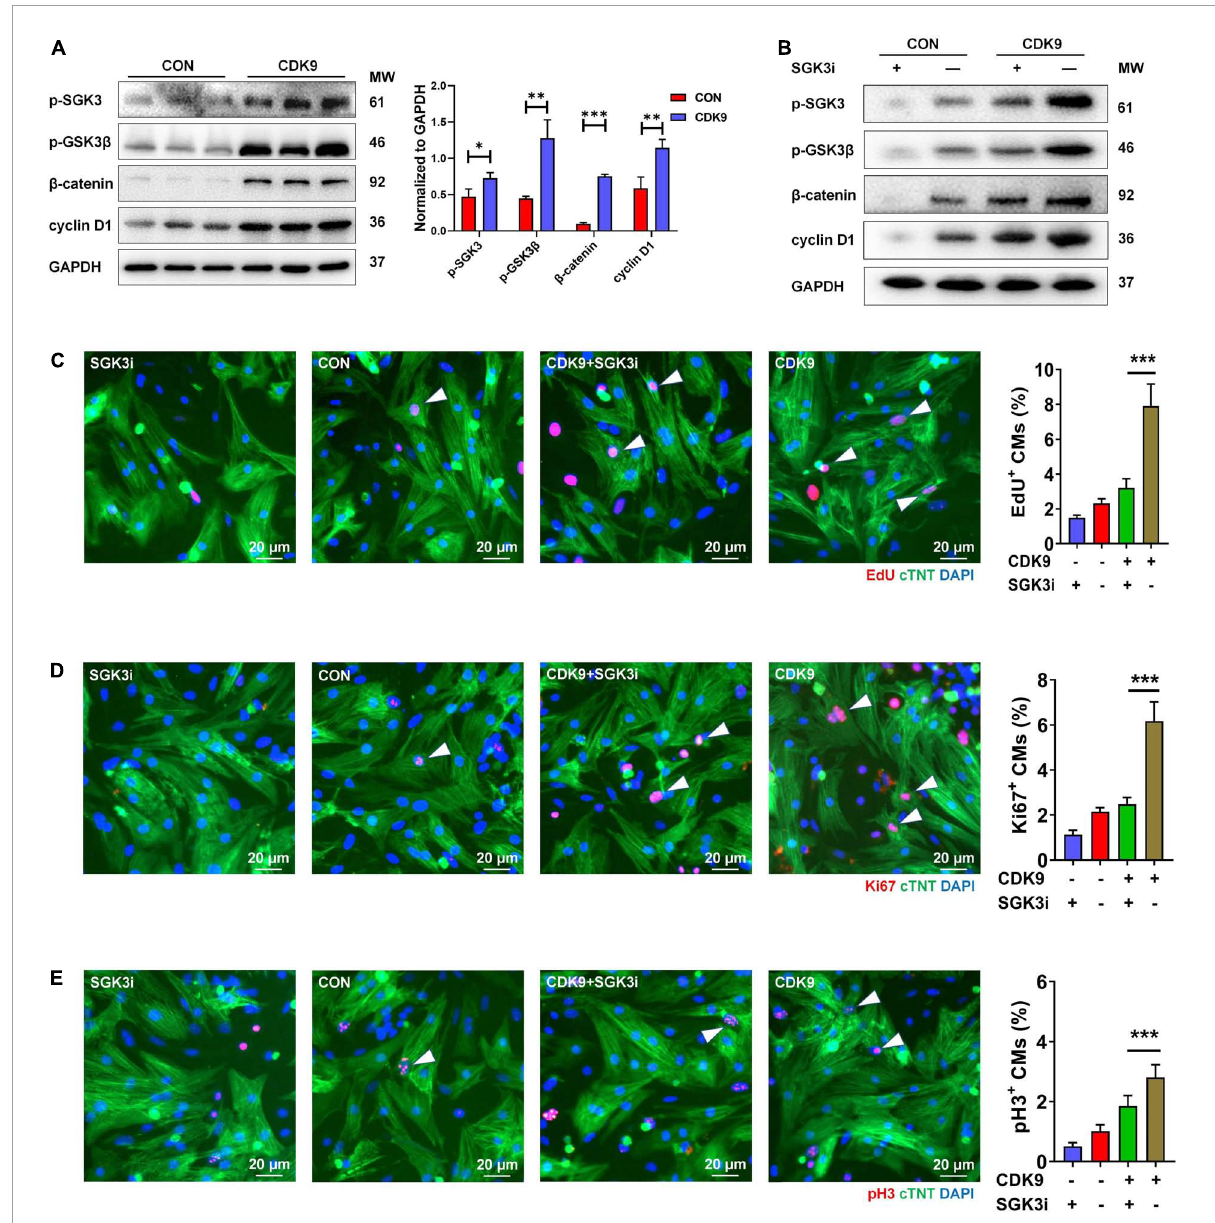
FIGURE6 CDK9 regulates myocardial regeneration and repair through SGK3/GSK-3 β / β -catenin axis in vitro . (A) p-SGK3, p-GSK3 β , β -catenin and cyclin D1 proteins of ventricular myocardium in adult mice injected with Ad5: cTnT-CDK9 (CDK9) after MI detected by western blot. (B) p-SGK3, p-GSK3 β , β -catenin and cyclin D1 proteins of neonatal CMs were detected by western blot after being transfected with CDK9 and/or Ad5:SGK3 RNAi (SGK3i). (C–E) CM proliferation is quantified by immunofluorescence for DNA synthesis (C) , cell-cycle activity (D) , and mitosis (E) in CMs transfected with CDK9 and/or SGK3i ( n = 6). Scale bars, 20 µ m; CMs indicate cardiomyocytes, MW indicates molecular weight; statistical significance was calculated with the unpaired Student t -test; data are presented as mean ± SEM, * P ≤ 0.05, ** P ≤ 0.01, *** P ≤ 0.001; each dot indicates a biological